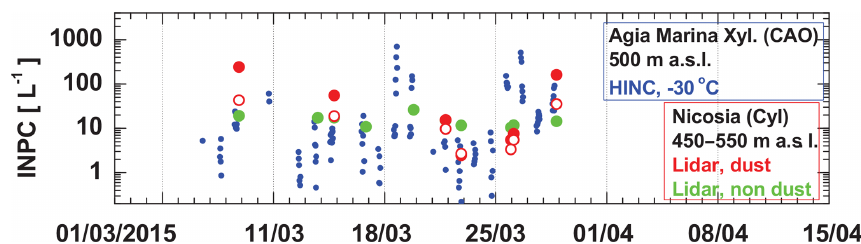
Figure 6. Comparison of in situ observations of the INPC (HINC, ETH Zurich; see the text for more explanation) at Agia Marina Xyliatou (about 500ma.s.l.) and lidar-based INPC estimations (mean values for the 450–550ma.s.l. height range) at Nicosia, about 25km downwind of Agia Marina Xyliatou. All in situ observations collected in March 2015 are shown. The green circles indicate lidar estimates of the INPC based on the D10 parameterization (for non-dust continental aerosol pollution) and the red circles are computed by using the D15 parameterization (for the dust aerosol fraction). For comparison, we also include dust INPC values (open red circles) obtained with the D10(d) parameterization (see Table 1). All INPC values (HINC, lidar) are given for − 30 ◦ C.